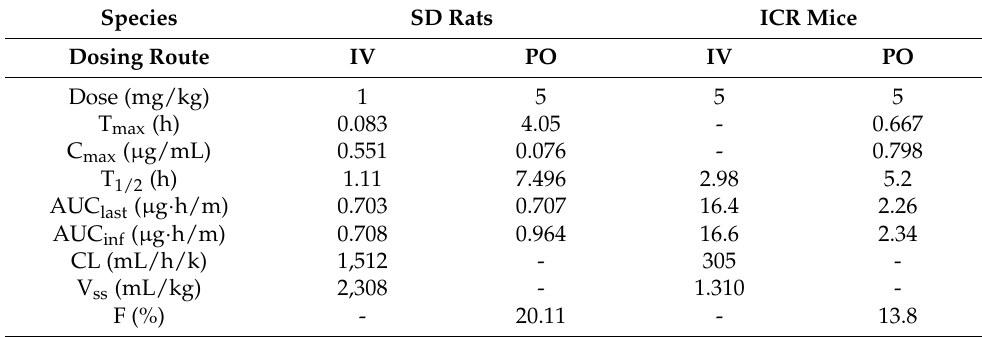
Table 3. PK Parameters of the Compounds 7c in SD Rats and ICR Mice.